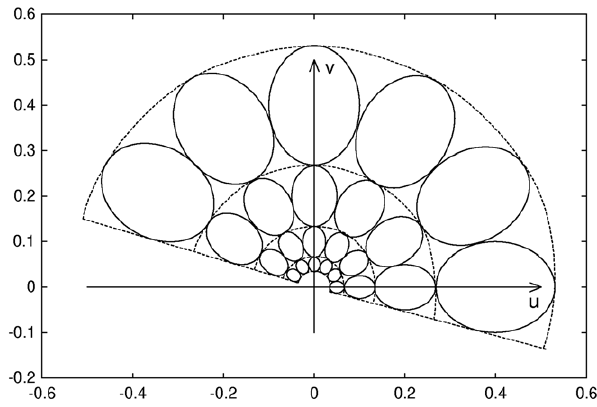
Figure 8. The elliptical contours indicate the half-peak magnitude iso-curves of the Gabor filters, in the frequency domain, at 6 orientations and 4 scales. At each scale, mean filter response is invariant to rotation.